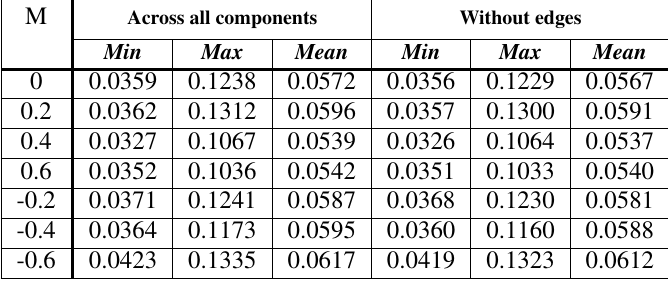
TABLE III. Relative Root Mean Square Deviation – using WPT